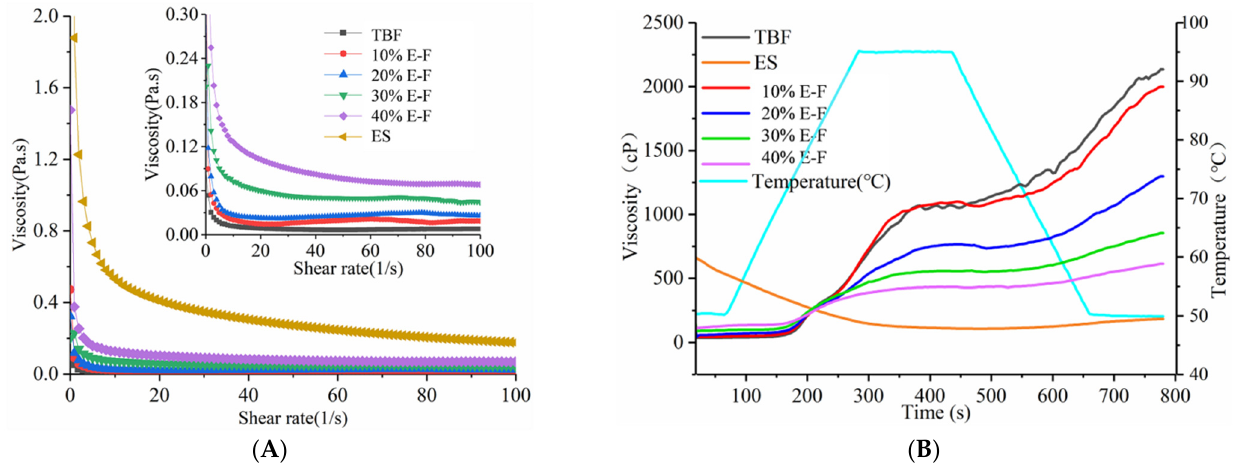
Figure 2. The dynamic ( A ) and pasting viscosity curves ( B ) of TBF, ES, and blended flour. ES and TBF represent extruded Tartary buckwheat starch and Tartary buckwheat flour, respectively. The 10% E-F, 20% E-F, 30% E-F, and 40% E-F represent that the addition of extruded starch in the blended flour was 10%, 20%, 30%, and 40%, respectively. Table 1. The pasting properties of ES, TBF, and blended flours.